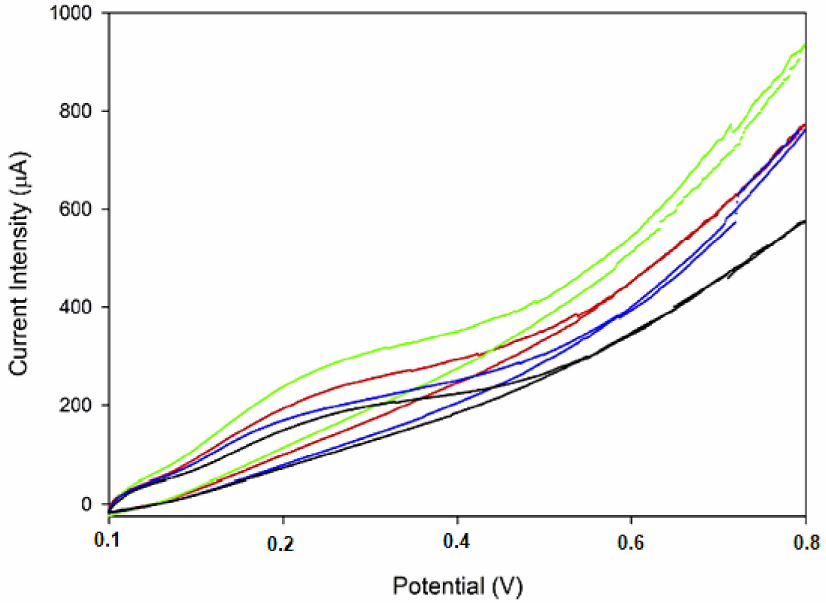
Figure 6. CV of oils obtained from each of the four categories: Leccino (black); Moraiolo (blue); Frantoio (red); Nostrale (green). Published from [46] with the permission of the